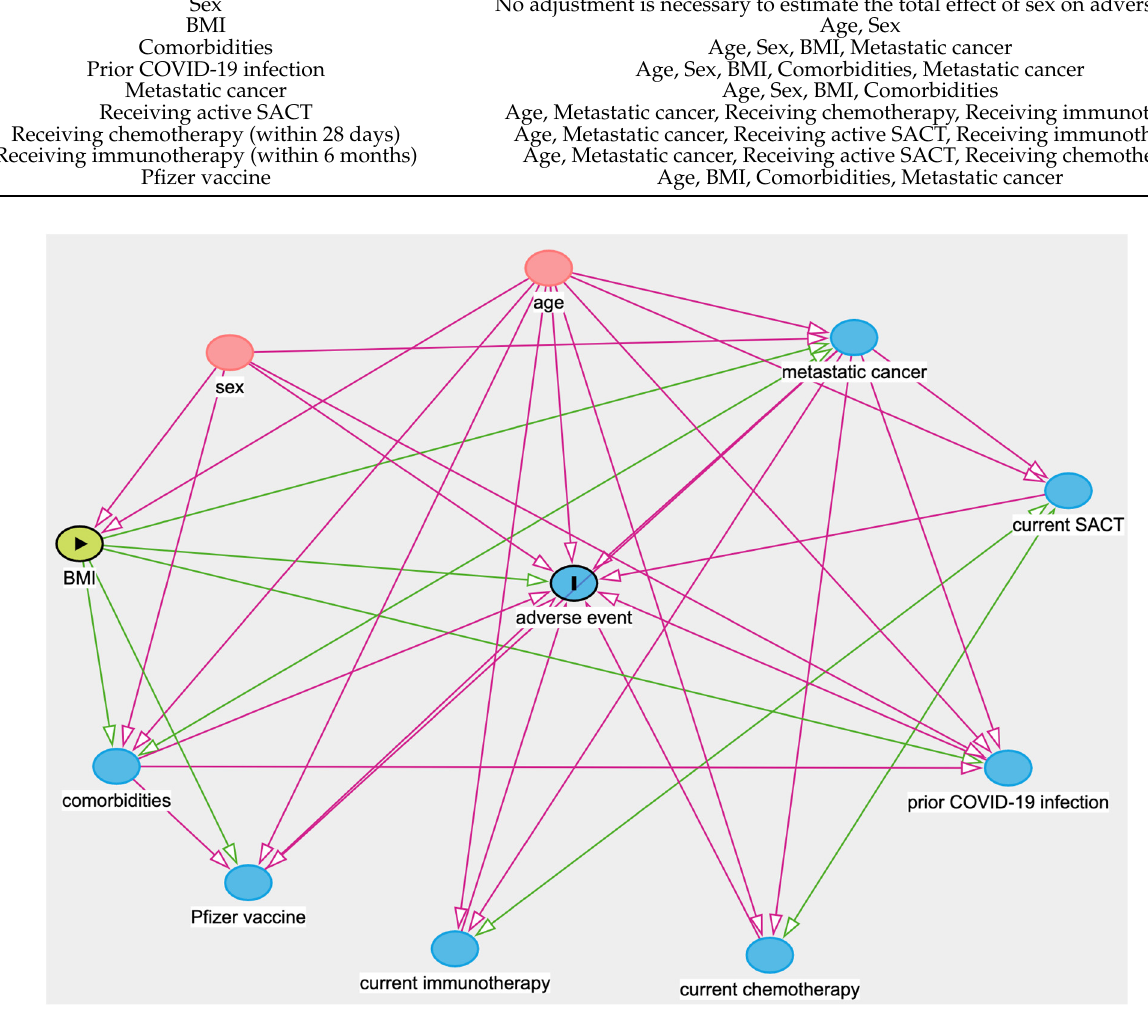
COVID-19 illness in adult cancer survivors in the United States. J. Natl. Cancer Inst. 2021 , djab012, doi:10.1093/jnci/djab012.